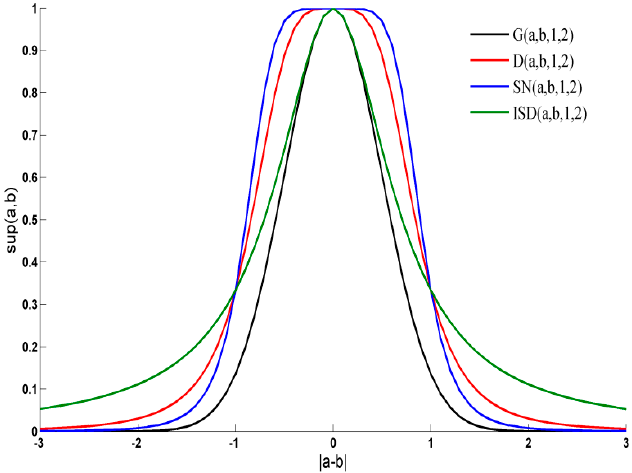
Figure 2. The comparison of different support degree functions.